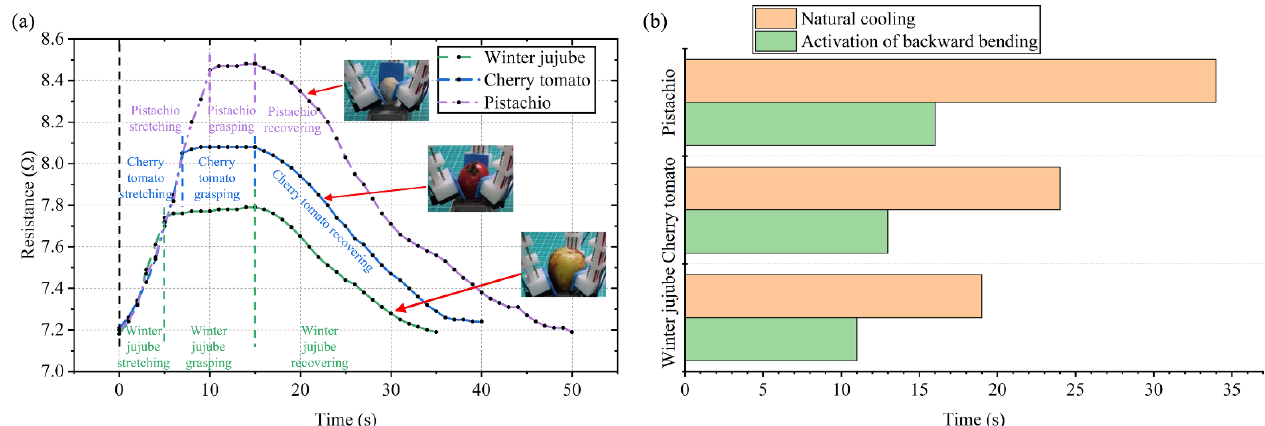
Figure 13. The changes in the resistance value of the gripper’s sensor without a load and recovery time comparison. ( a ) Resistance changes of the sensor during the grasping process (the stretching stage is not included). ( b ) The time required for the gripper to return to its initial state (natural cooling vs. activation of backward bending). cooling vs. activation of backward bending).